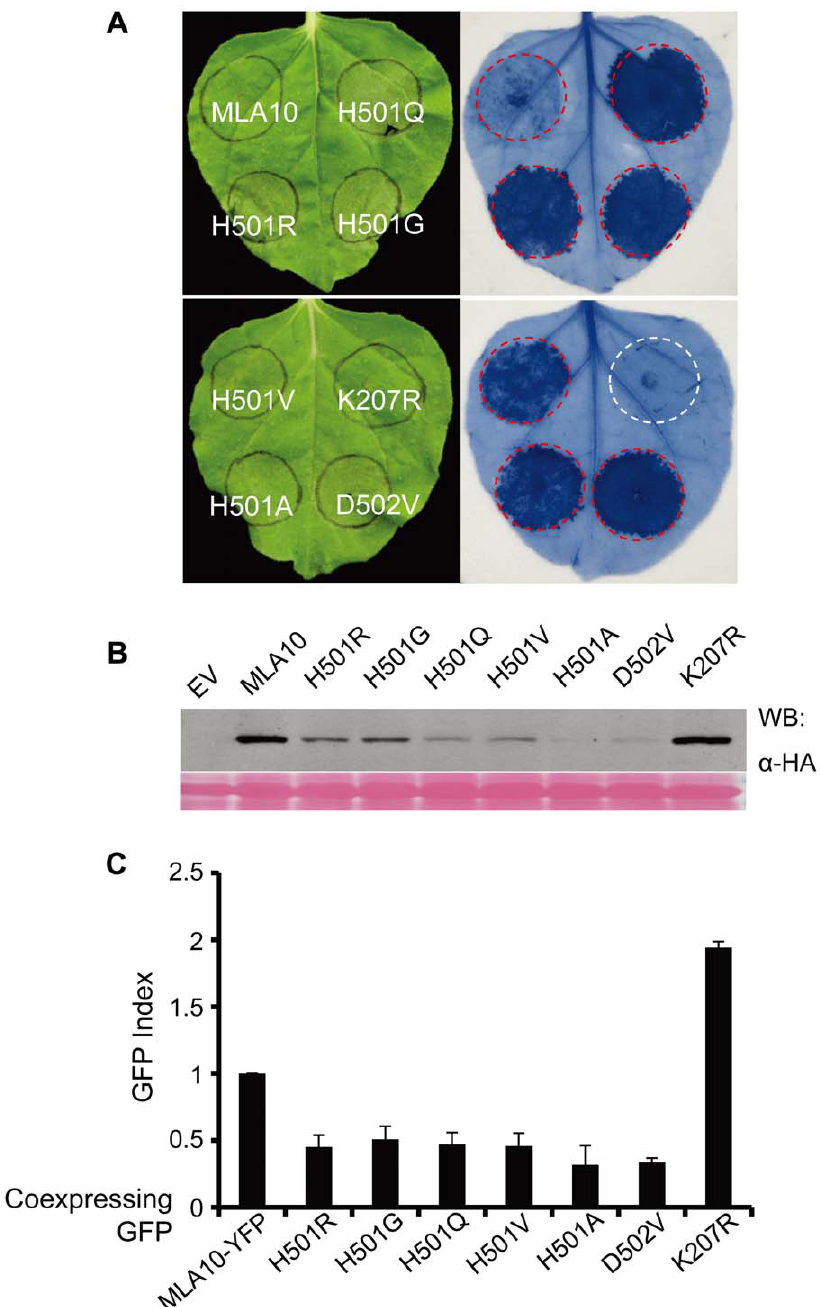
Figure 3. Cell death activity analyses of MLA10 MHD or P-loop mutant variants in N.benthamiana and barley. ( A ) Analysis of cell death Inducing activity of MLA10 WT and its mutant variants in N. benthamiana . Individual C-terminal 3 6 HA tagged MLA10 WT and mutant proteins were expressed by Agro-infiltration in N. benthamiana , and cell-death triggered by each protein was scored by trypan blue staining at 24 hpi. ( B ) Protein expression of MLA10 WT and its mutant variants. Total proteins were extracted from N. benthamiana leaves at 22 hpi and followed by immunoblotting. MLA10 was detected using an anti-HA antibody. ( C ) Analysis of cell death Inducing activity of MLA10 mutant variants in barley. Plasmids of MLA10 MHD motif mutants (H501R/G/Q/V/A, D502V) and a P-loop mutant (K207R) were co-expressed with a GFP maker plasmid in barley epidermal cells using biolistic delivery. The histogram bars represent the number of GFP expressing cell of each co-expression experiment standardized to the MLA10-YFP as control (see Materials and Methods). GFP expressing cells were scored as vital cells at 36–42 hrs post bombardment. The error bars represented SE of three representing experiments from more than five replicates. doi:10.1371/journal.ppat.1002752.g003 transient expression and confocal imaging we detected for respective controls (Figure S2). Our data are consistent with CC(L18E)-YFP or FL(L18E)-YFP in N. benthamiana or barley cells previously proposed sequence constraints acting on the CC similar nucleocytoplasmic distribution patterns compared to the domain for MLA disease resistance [25,52] and assign a critical